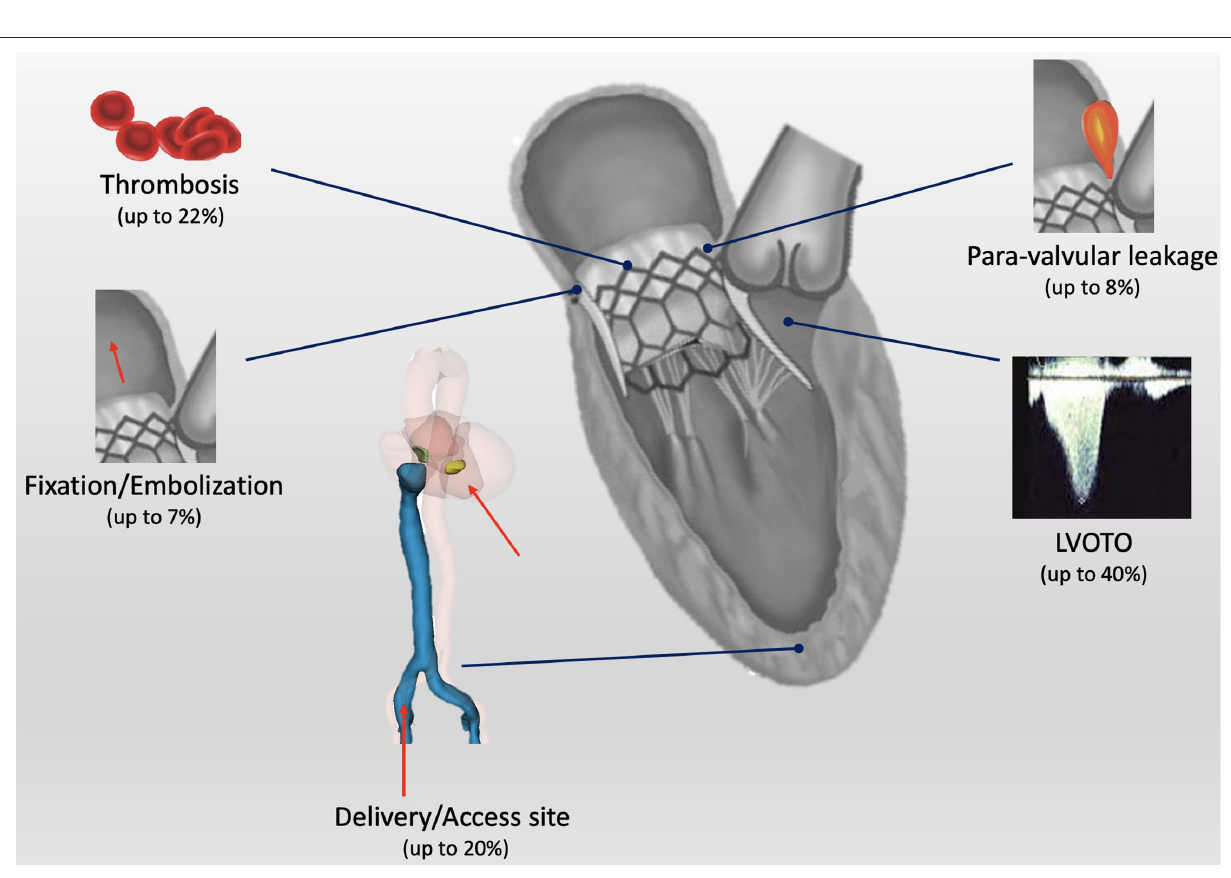
important limitation for TMVI in all subsets, with special regards to ViMAC. The LAMPOON technique can be a possible solution to LVOTO although it requires highly experienced operators and